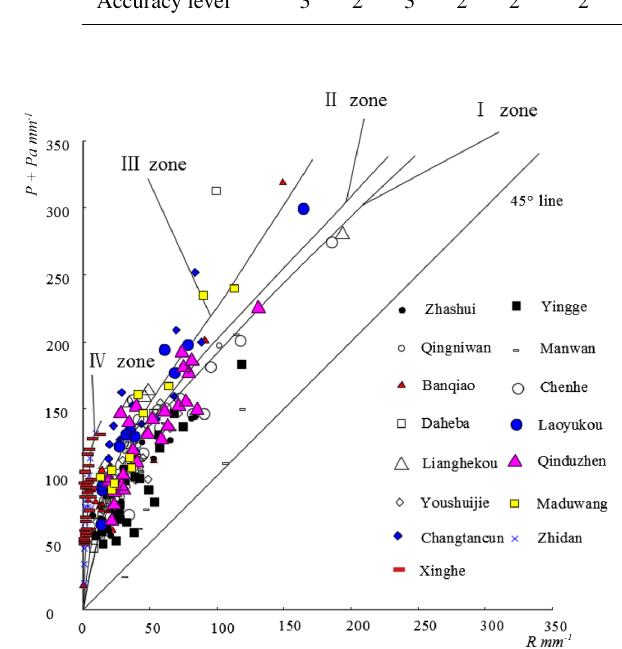
Figure 6. Regionalisation of coaxial correlation